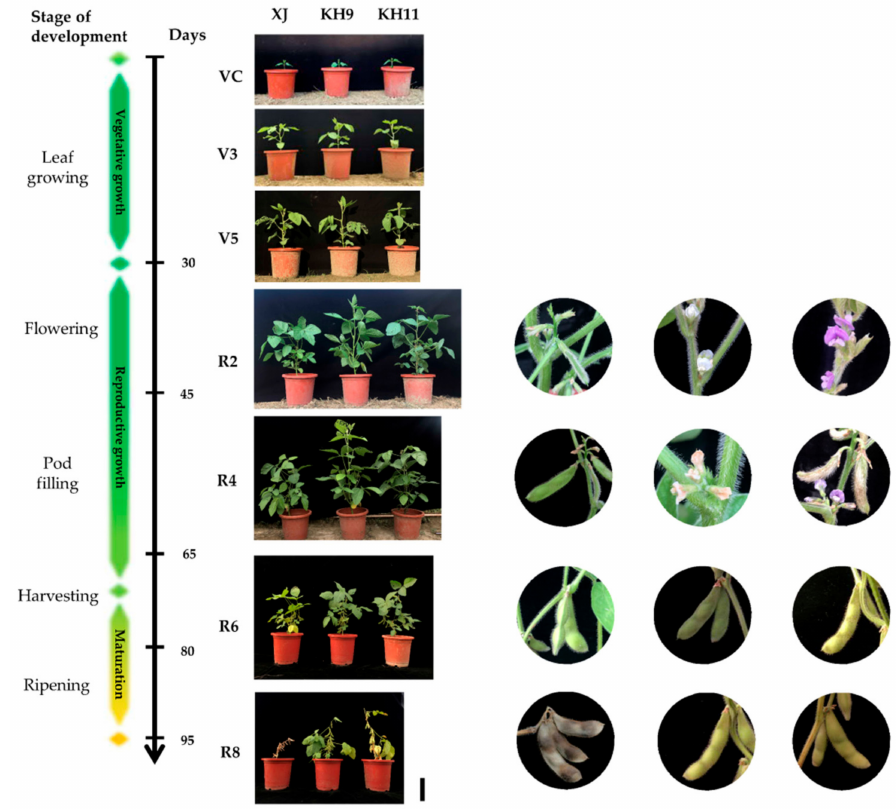
Figure 1. Phenotypes of XJ, KH9, and KH11 edamame cultivars during the VC to R8 growth stages. Photos of flowers and pods were taken when the plants entered the reproductive growth stage. planting day. Bar = 10 cm. XJ, Xiang-Ji. KH9, Kaohsiung No. 9. KH11, Kaohsiung No. 11. VC, vegetative cotyledon stage. V3, V5, vegetative stages 3, 5. R2–R8, reproductive stages